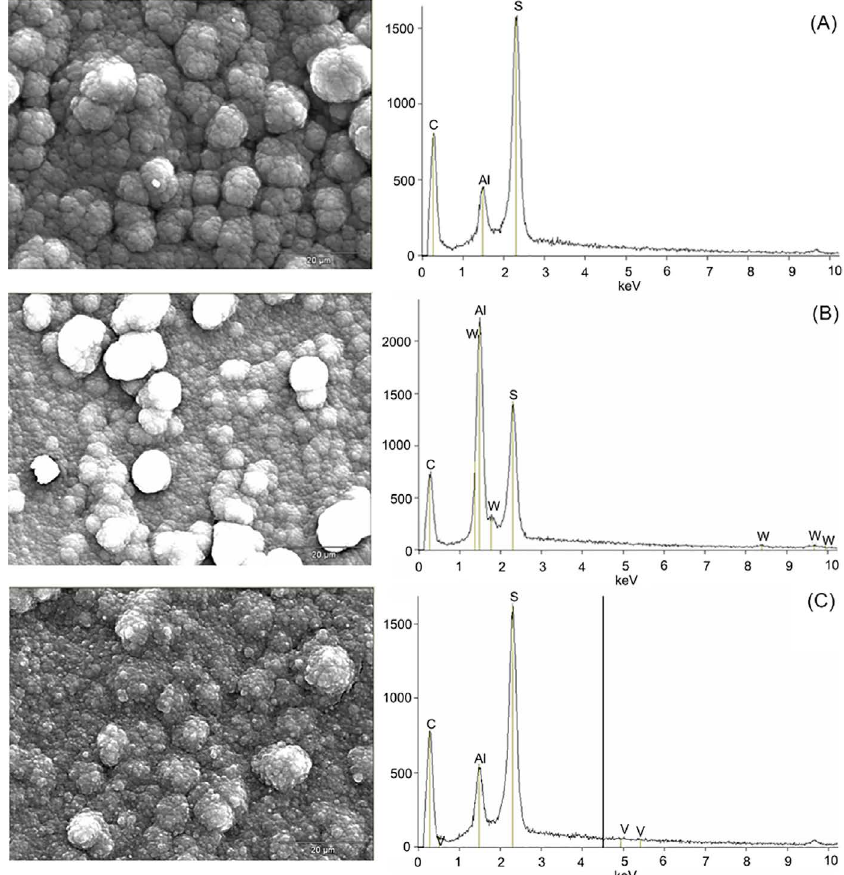
Figure 2. SEM and EDS analysis of the (A) PPy/DBS; (B) PPy/DBS/TUN; (C) PPy/DBS/VAN films.